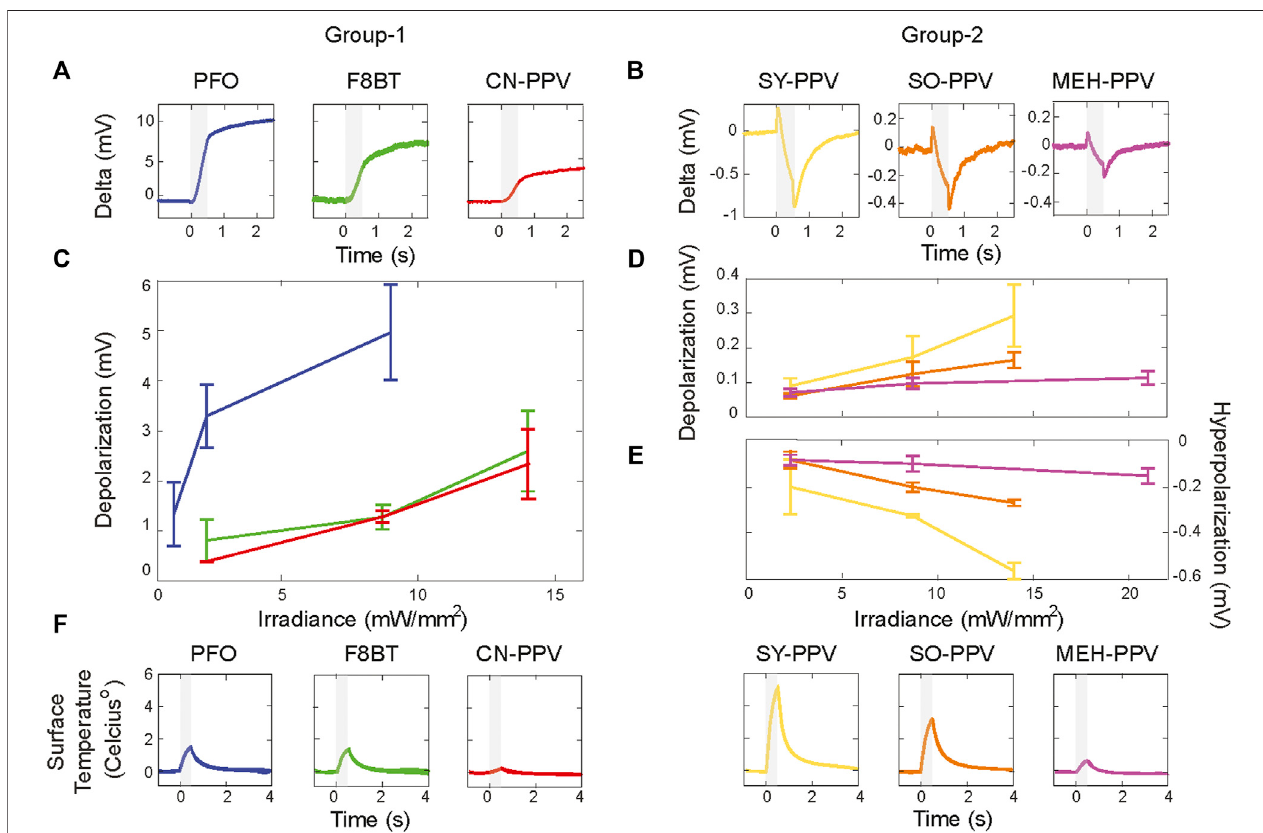
FIGURE 4 | Plurality of response types of the cell membrane potential of HEK293T cells following photon absorption in adjacent semiconducting polymers. Cell responses recorded for each material at different light intensities using narrowband fi ltered LEDs to match excitation wavelength to the absorbance peak of thin fi lm (390 nm for PFO, 473 nm for CN-PPV, F8BT, SY-PPV, and SO-PPV, and 548 nm for MEH-PPV). Two broad types of responses are observed in response to 500 ms illumination(grayareas highlightthelightirradiation period):group-1materials PFO, F8BT,and CN-PPV (A) show irreversible depolarization whichextendsbeyond the light period; group-2 materials (SY-PPV, SO-PPV, and MEH-PPV) (B) show reversible multiphasic stimulations. Representative traces are depicted for the highest employed irradiation power, t = 0 corresponds to light onset. (C – E) . Amplitude during illumination versus irradiation power and material (mean ± SEM, N = 2 – 6 cells per tested irradiance). (F) Surfacetemperaturemeasured during 500 ms illuminationrevealsthe largest temperature shifts forSY-PPV fi lms, followed in decreasing order by SO-PPV, PFO, F8BT, MEH-PPV, and CN-PPV. The irradiance used for each fi lm corresponds to the highest power tested during cellular